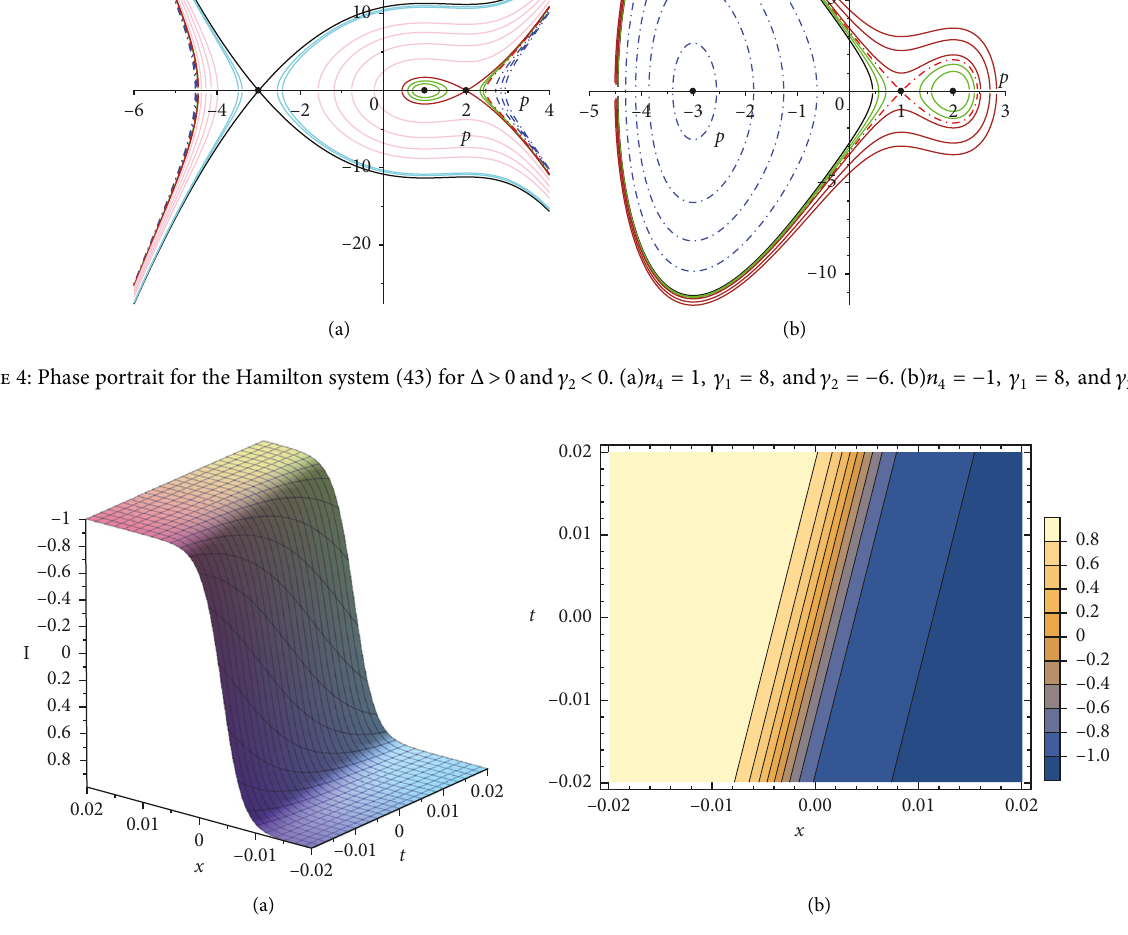
2 , ρ 0 . 1 , and σ (cid:31) (cid:31)